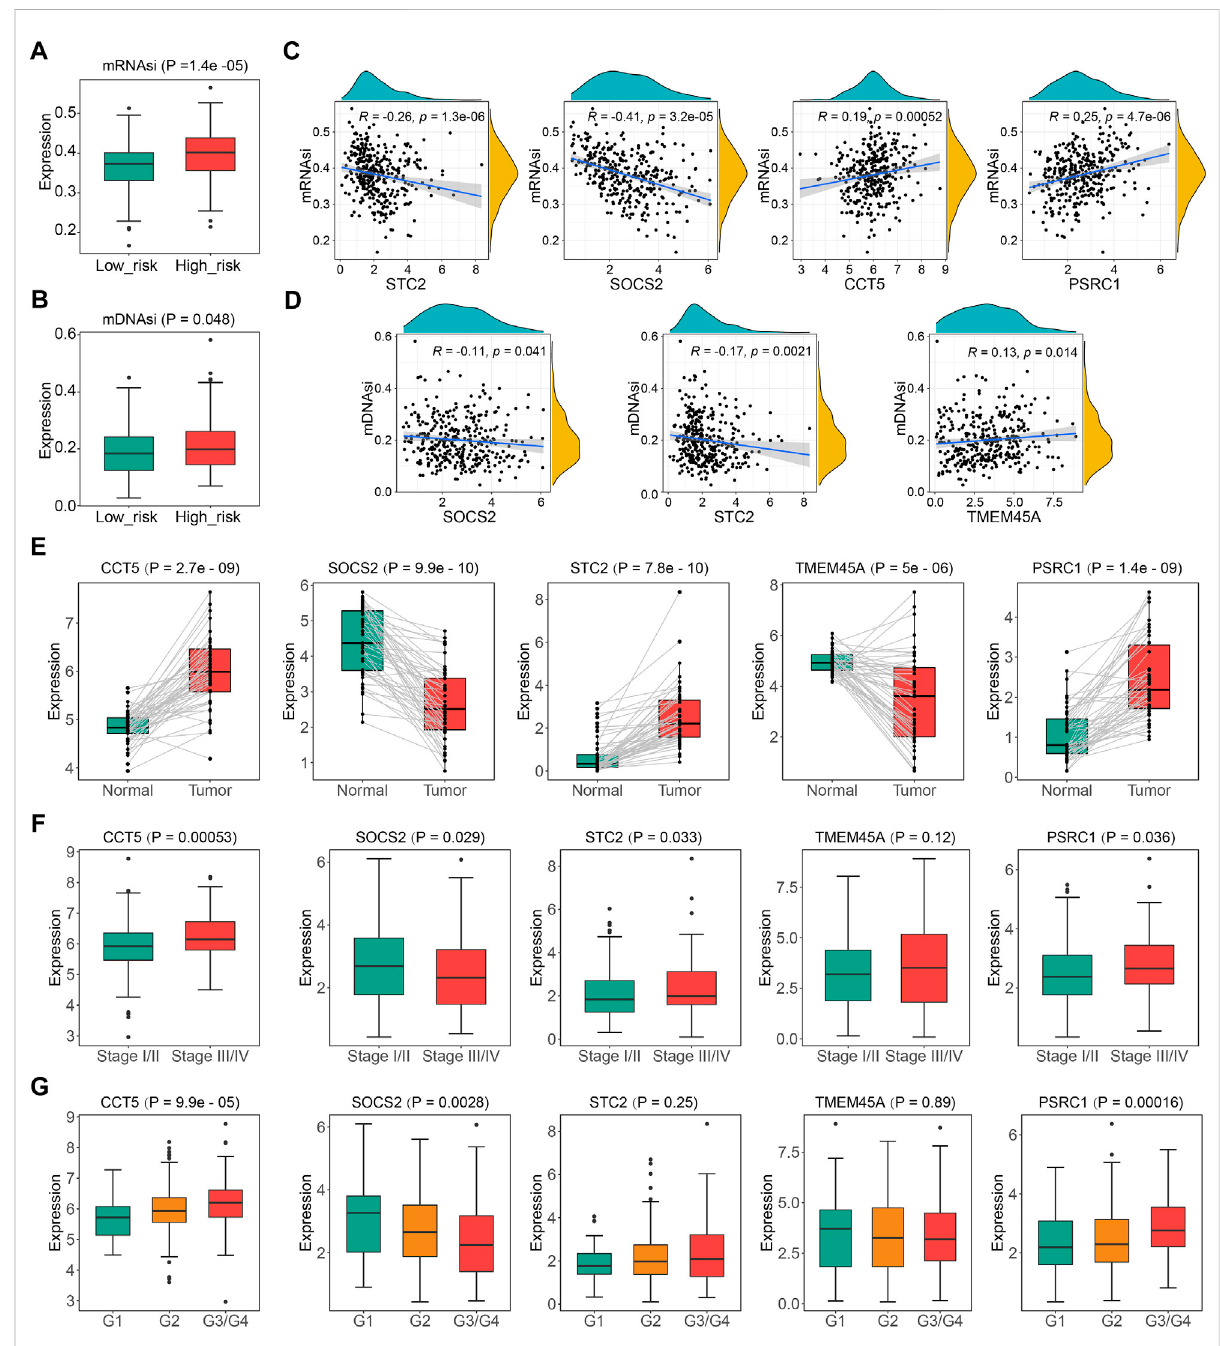
FIGURE 9 Comprehensive analysis of the fi ve CSGscore genes using the TCGA-LIHC dataset. (A,B) Comparison of mRNAsi (A) and mDNAsi (B) between the high- and low- CSGscore risk groups. (C,D) Spearman correlations of the expression of CSGscore genes and mRNAsi (C) or mDNAsi (D) . Only signi fi cant results are shown. (E) Validation of the differential expression of the fi ve CSGscore genes between the tumor and normal tissues with paired boxplots. (F,G) Comparison of the expression of the fi ve CSGscore genes between subsets of stage and tumor